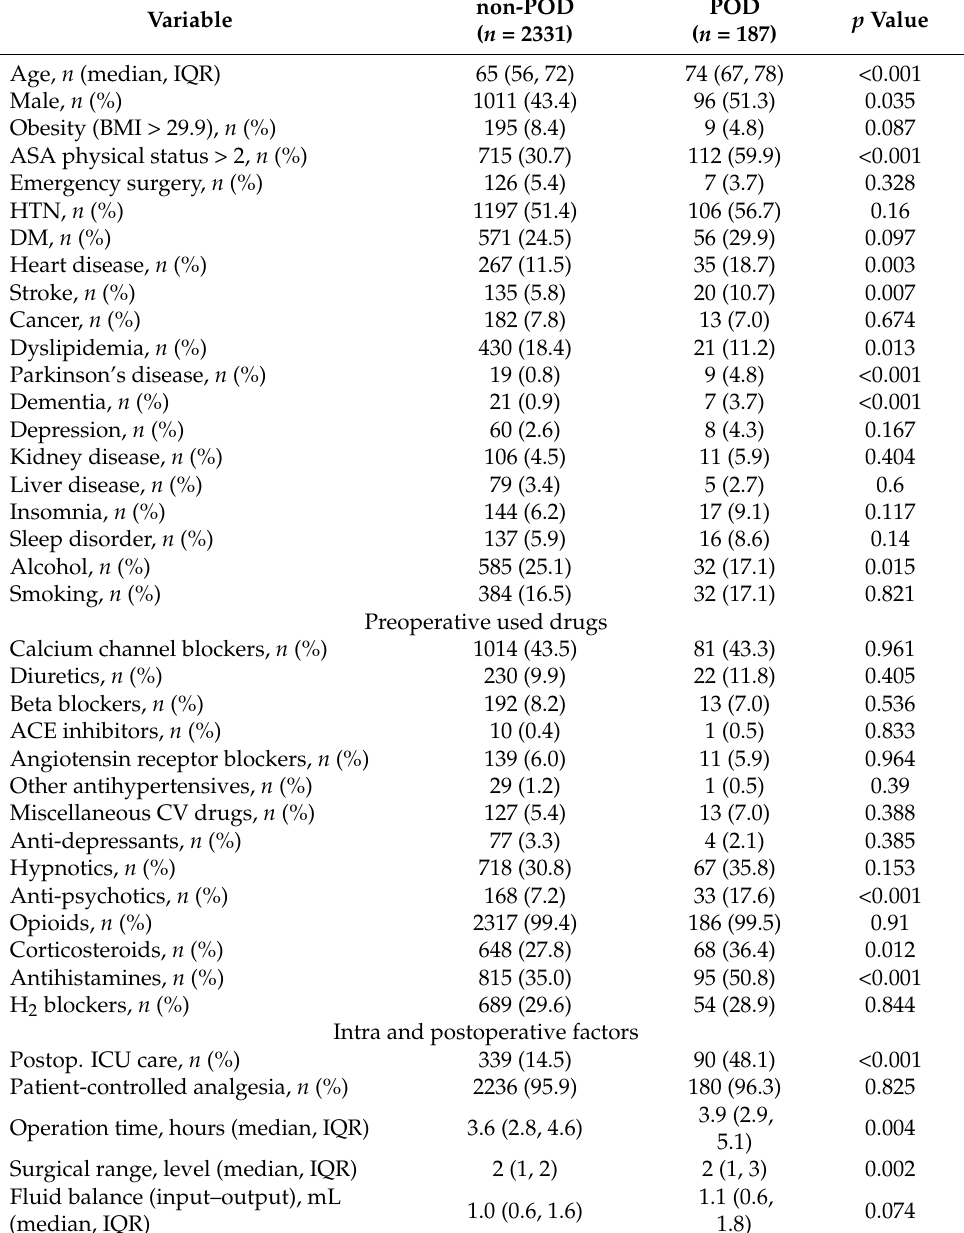
Table 1. Preoperative, intraoperative, and postoperative risk factors of the non-POD and POD groups.